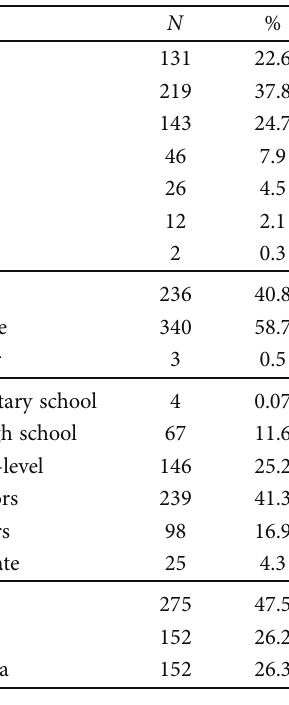
Table 1: Sample demographics ( N = 579